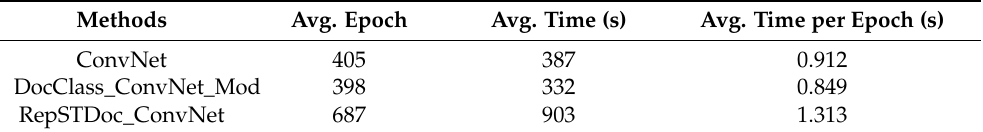
Table 7. The comparison of the time.